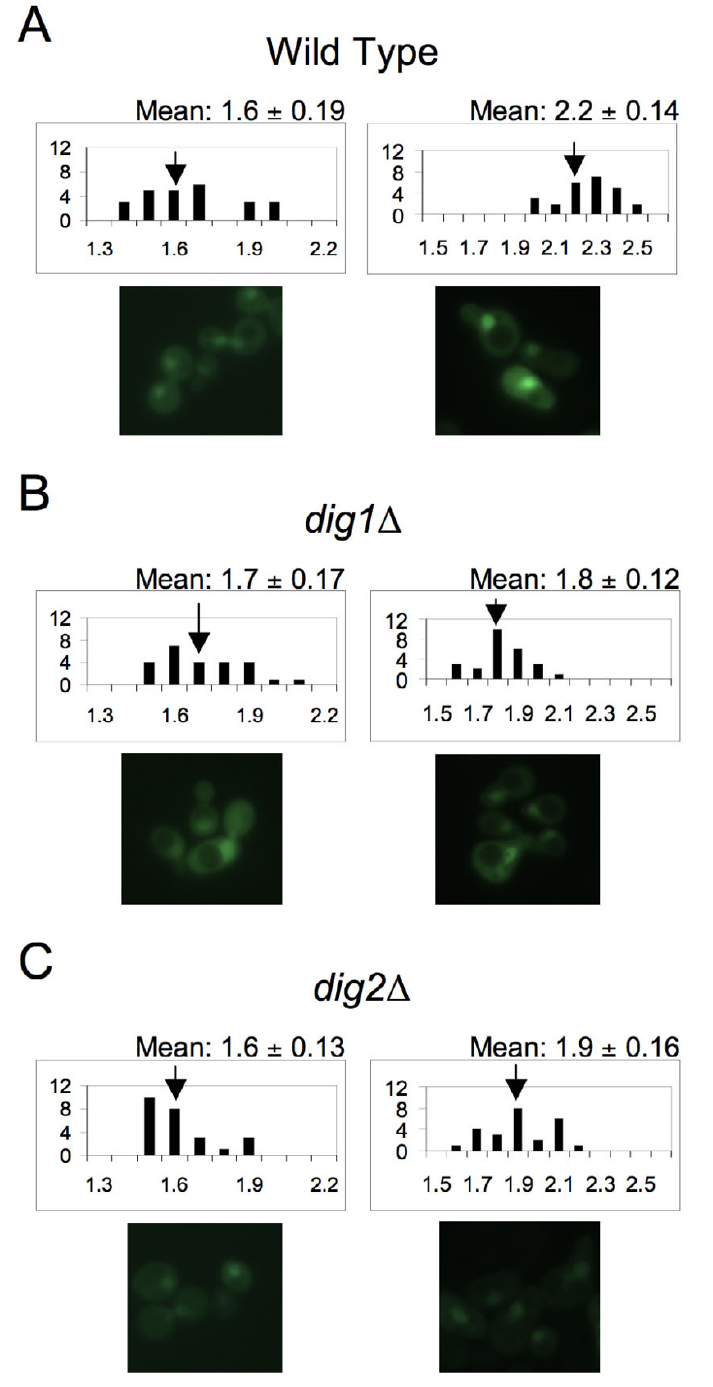
Figure 1 Dig1 and Dig2 are required for the pheromone-induced nuclear accumulation of Fus3 . Strains of the indicated genotype were transformed with Fus3-GFP and grown to mid-log phase. The cultures were then split and grown with or without the addition of 12 nM pheromone. Images were acquired from the treated and untreated cells three hours later. The RNCF values were determined as described in the Materials and Methods, and their distributions represented in histograms. The number of cells ( y axis) is plotted as a function of the RNCF values ( x axis). Mean RNCF values are indicated ± s.d. In each panel, the untreated and treated cultures are repre- sented by the left and right histograms, respectively. Arrows indicate the mean RNCF value for each culture. Representative micrographs from which the quantitative data were derived are shown beneath each histogram. (A)Wild type cells; (B) dig1 Δ cells; (C) dig2 Δ